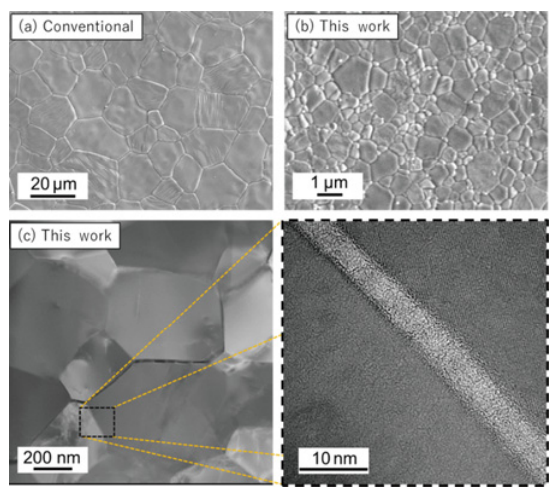
Fig. 4 Microstructures of (a) conventional and (b) advanced alumina ceramics by SEM. (c) Microstructures of advanced alumina ceramics observed by